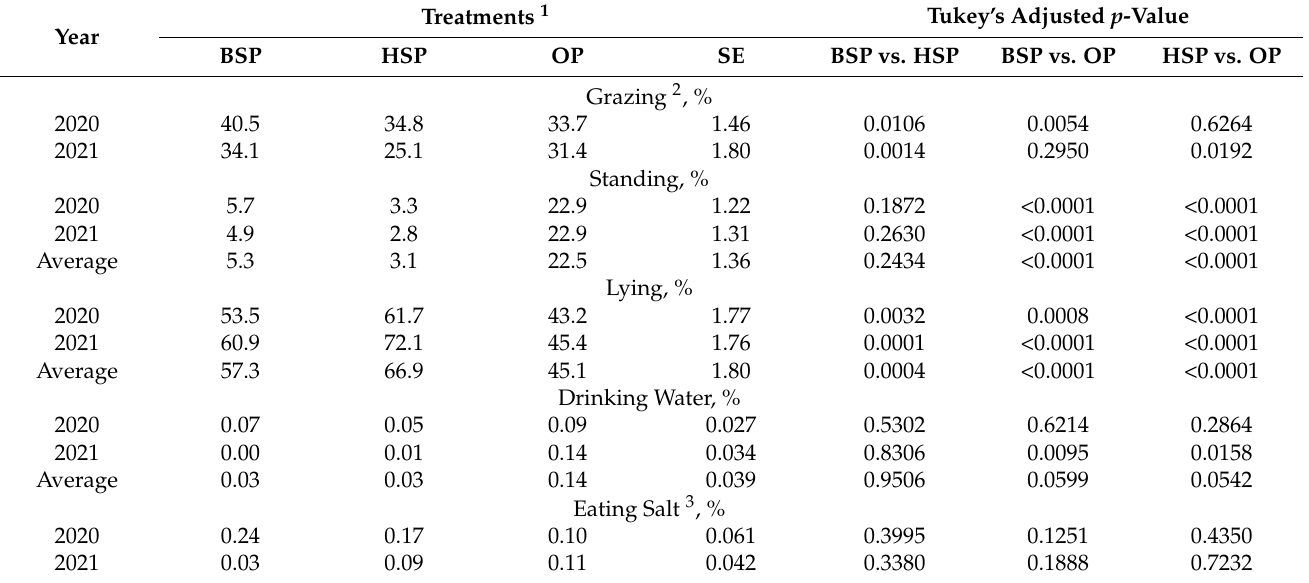
Table 7. Percent of time (0700–2100 h) spent by ewes within different behavior categories in either open pasture (OP), black walnut silvopasture (BSP), or honeylocust silvopasture (HSP) treatments during the summers of 2020 and